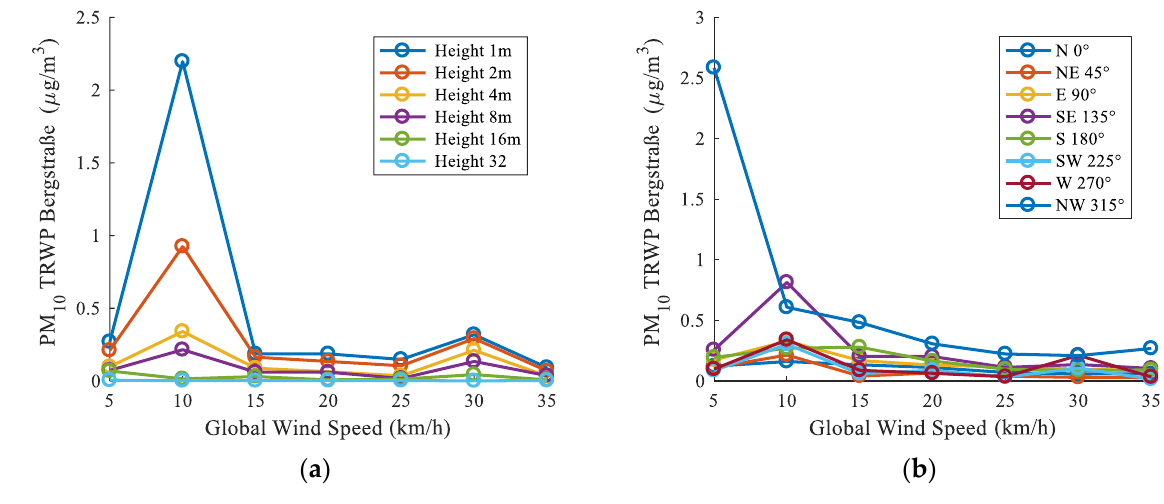
Figure 9. Correlation between global wind conditions and local PM 10 concentrations (Bergstraße): ( a ) influence of global wind speed (global wind direction: west) — ( b ) influence of the global wind direction (height above the road surface: 4 m).